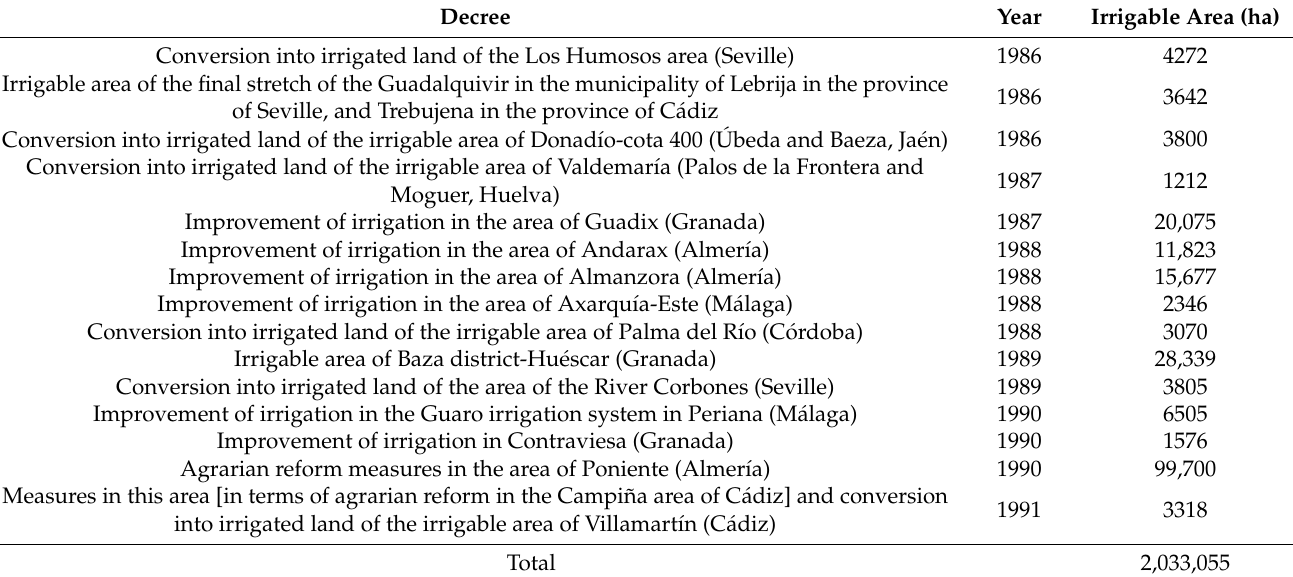
Table 1. Declarations of general interest regarding the Autonomous Community of Andalusia in terms of irrigation